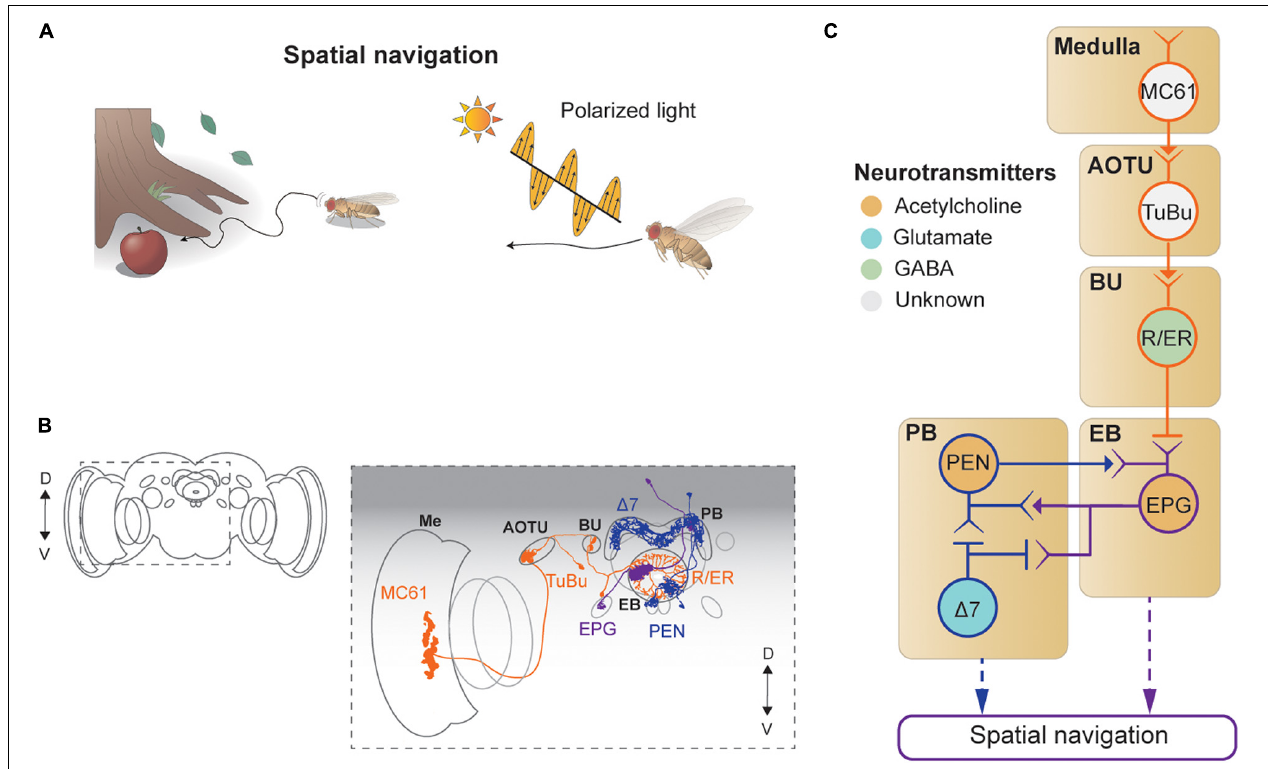
FIGURE 6 | Neural circuits underlying visually-guided spatial navigation. (A) Drosophila navigates environments based on visual landmarks, sun position, and polarization. (B) Schematic illustration of structures of neurons described in panel (C), adapted from images in Omoto et al. (2017) and Hulse et al. (2021). Me: medulla, AOTU: anterior optic tubercle, BU: bulb, PB: protocerebral bridge, EB: ellipsoid body. (C) A schematic diagram of neural circuits involved in navigation and visual learning. The face color of a circle represents the type of neurotransmitters, and the line colors match those in panel (B)